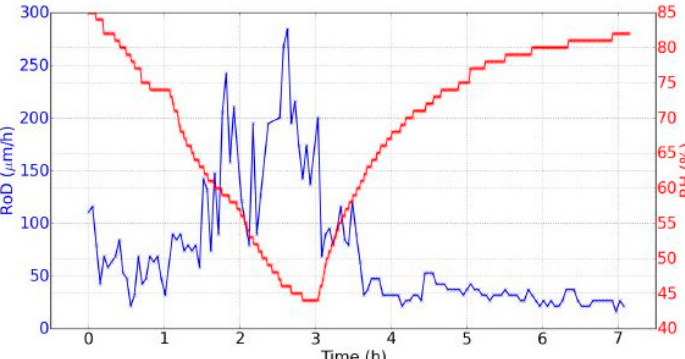
Figure 9. Evolution of the RH and the rate of displacement (RoD) during seven hours (day 7, one point every minute for the RH, and one point every three minutes for the RoD).